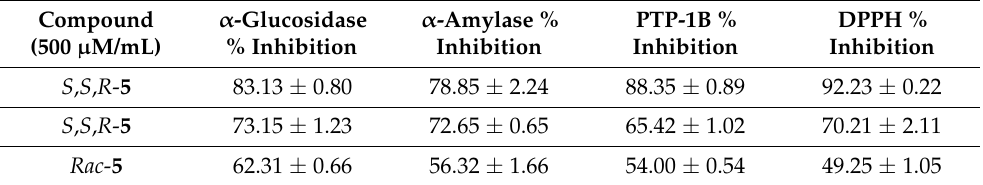
Table 1. Initial screening of major ( S , S , R - 5 ), minor ( S , S , R - 5 ) and racemic ( Rac - 5 ) for various in vitro targets.